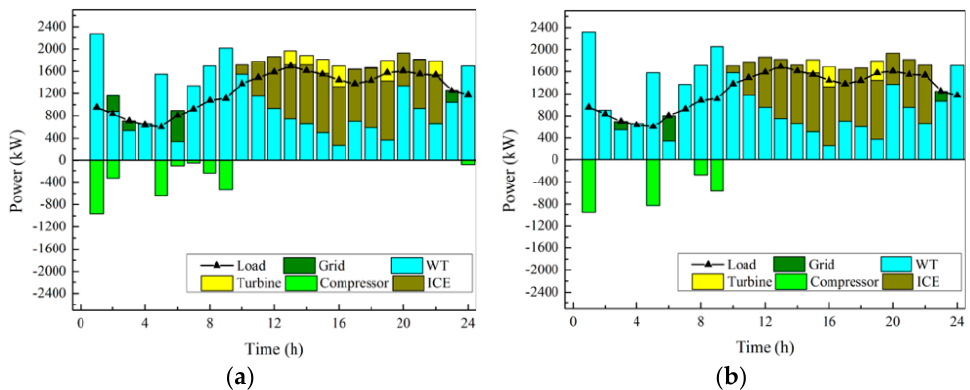
Figure 11. Operational power of electricity in summer: ( a ) without considering off-design characteristics; ( b ) considering the off-design characteristics.